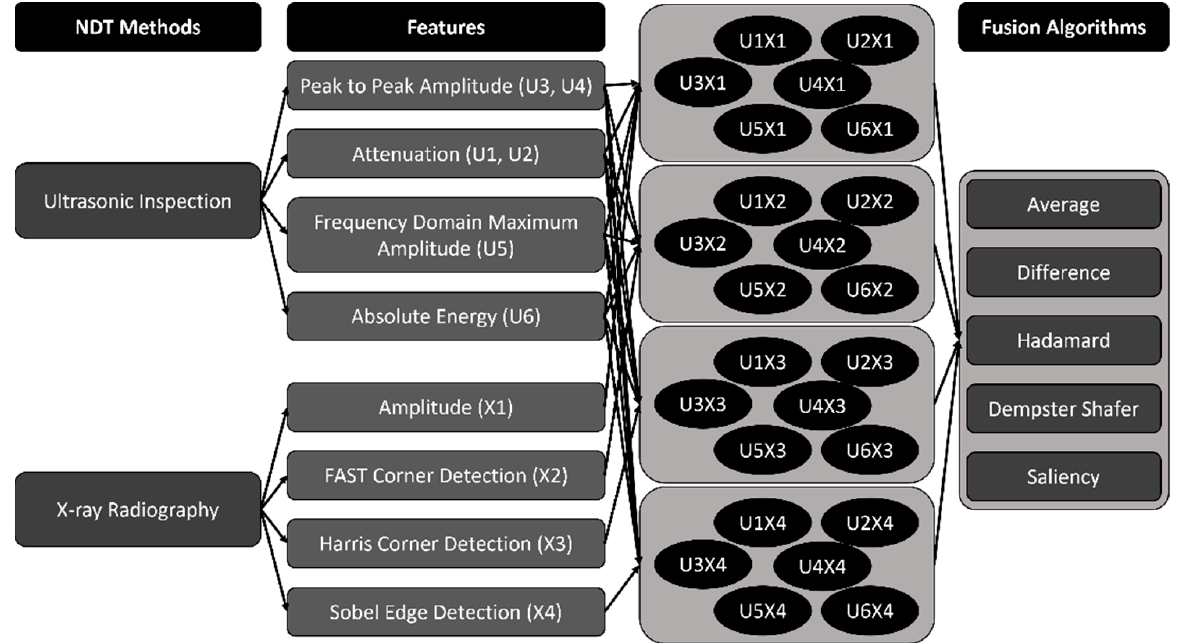
Figure 9. Workflow of data fusion.